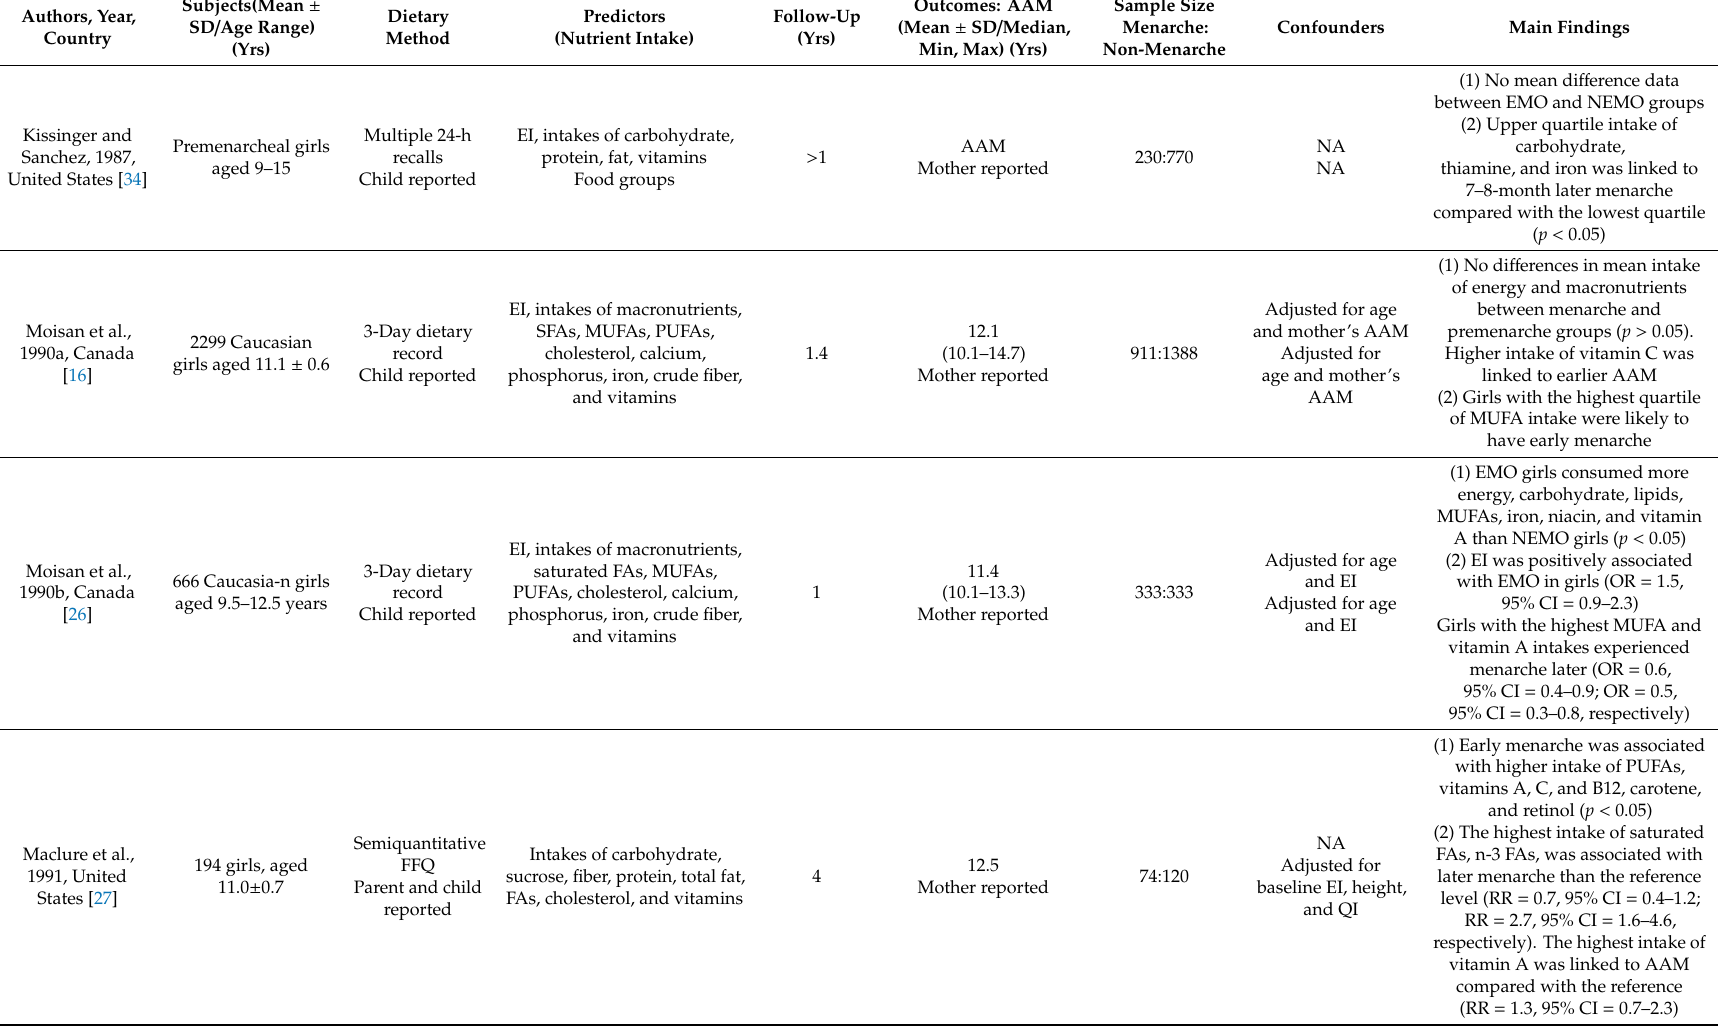
Table 1. Characteristics of studies included in the systematic